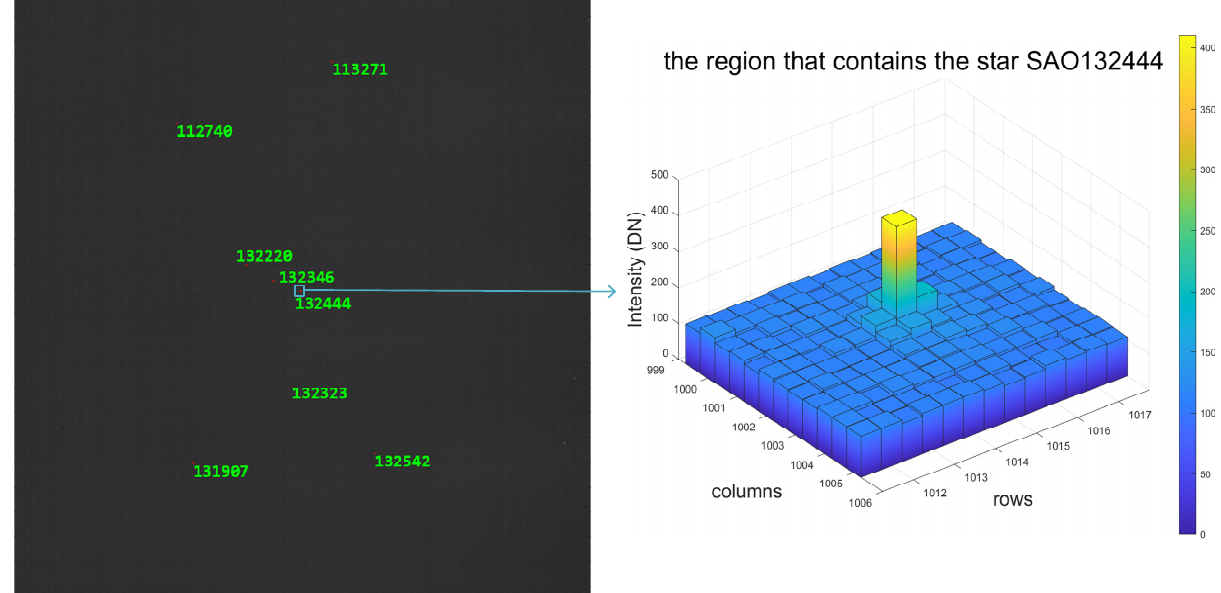
Figure 2. Recognition result of the star map taken by the non-irradiated CMOS image sensor. The numbers in the picture are the serial numbers of these stars in the SAO Star Catalog. In the zoomed version, DN (Digital Number) is the unit of gray value.